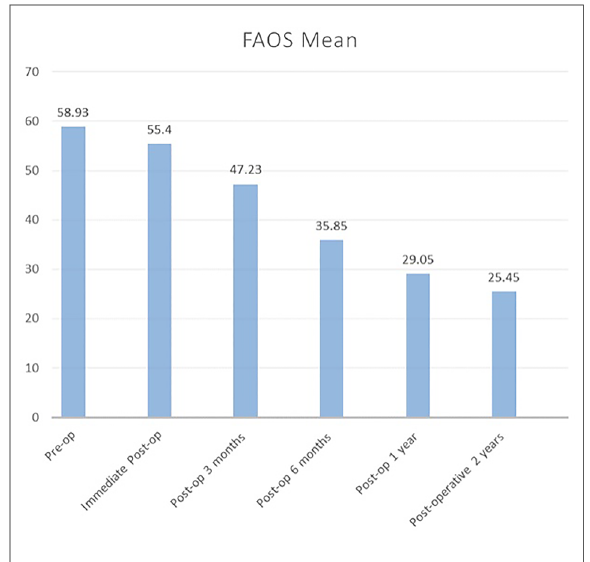
FIGURE 5 FAOS mean score for 2 years follow-up. FAOS, Foot and Ankle Outcome